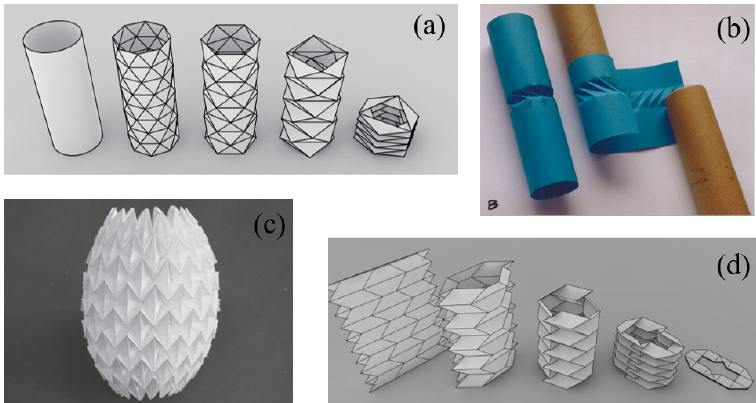
Figure 2. Cylindrical origami. ( a ) Yoshimura pattern. Reprinted with permission from [23]. Copyright 2010 Royal Society. ( b ) Kresling pattern. Reprinted with permission from [24]. Copyright 2008 Royal Society. ( c ) Waterbomb pattern. Reprinted with permission from [25]. Copyright 2016 Royal Society. ( d ) Tachi–Miura pattern. Reprinted with permission from [23]. Copyright 2010 Royal Society.